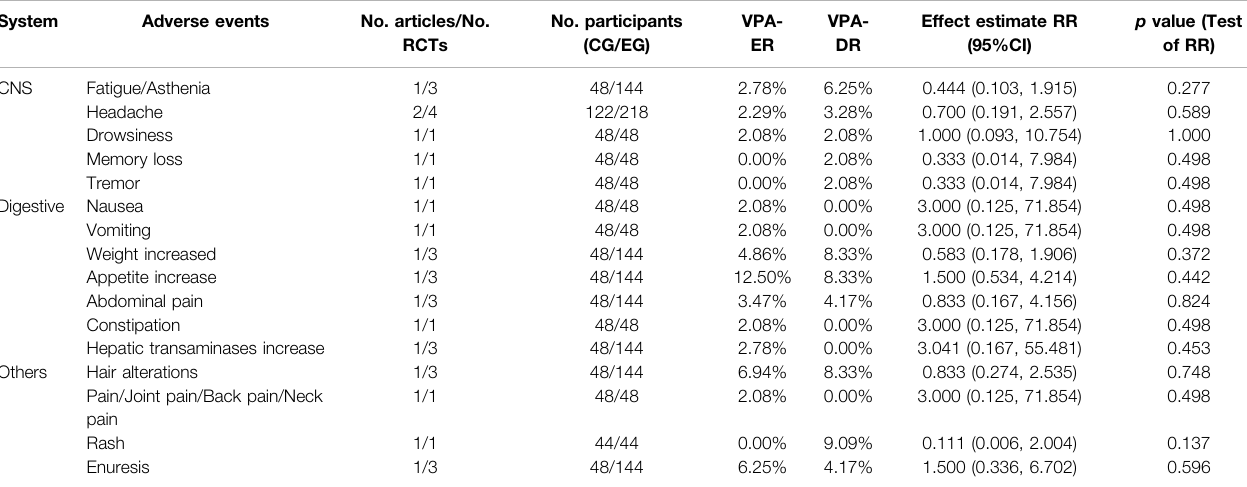
TABLE 4 | Adverse events (VPA-ER vs. VPA-DR). System Adverse